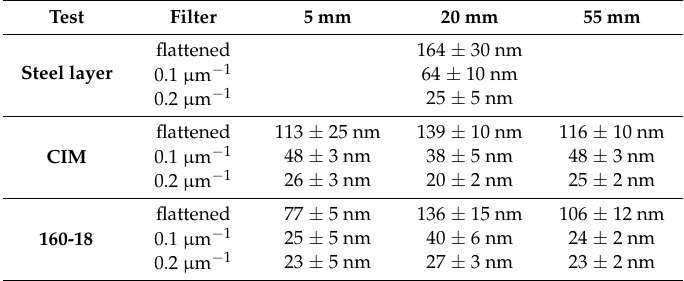
Table 2. Roughness of the steel layer and of the molded samples CIM and 160-18 at 20 mm distance from the gate.